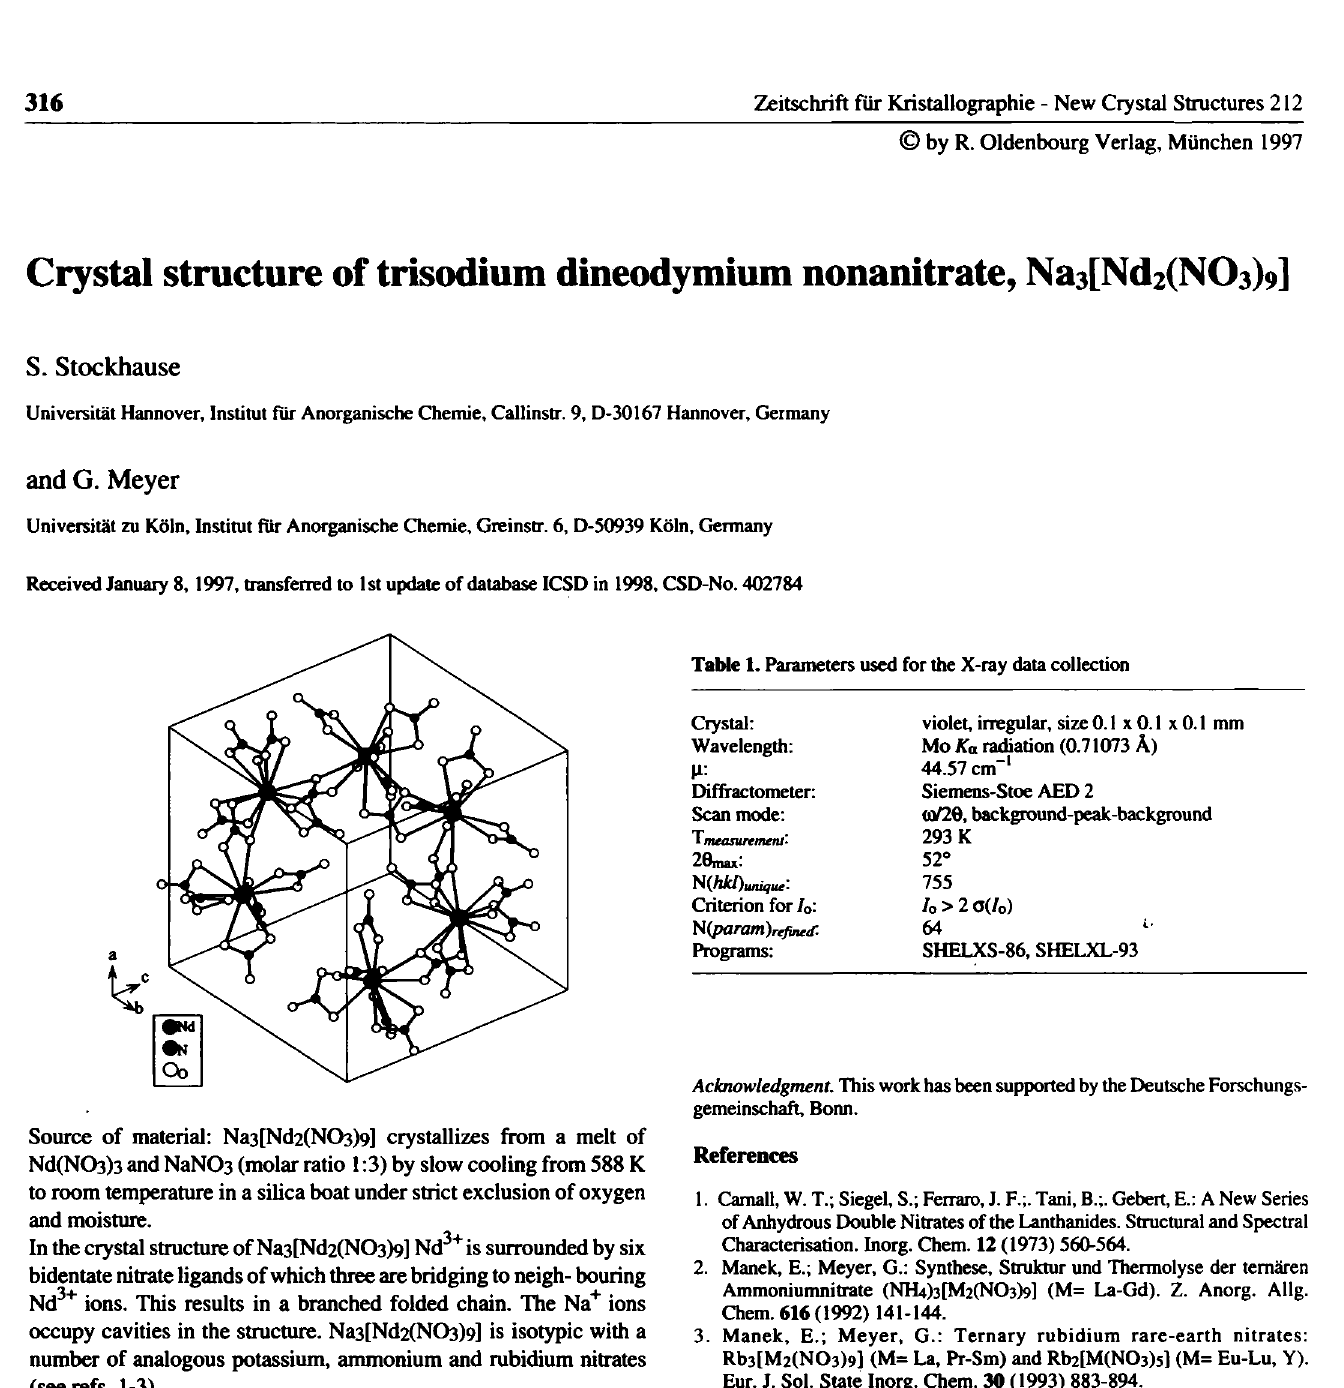
Table 2. Final atomic coordinates and displacement parameters (in Â 2